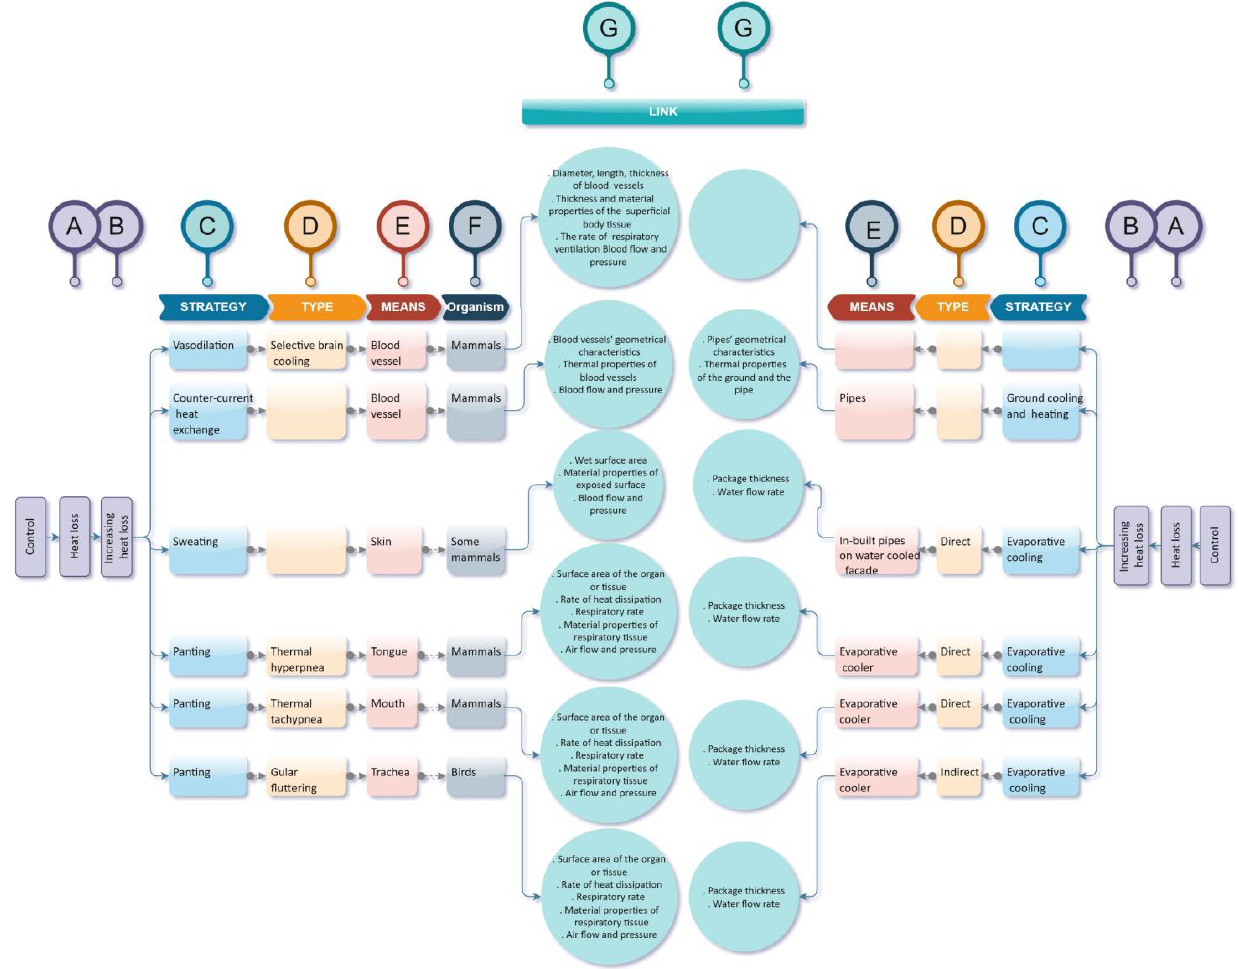
Figure 3. A section of the ThBA related to active strategies for animals, adapted from Imani and Vale [41].